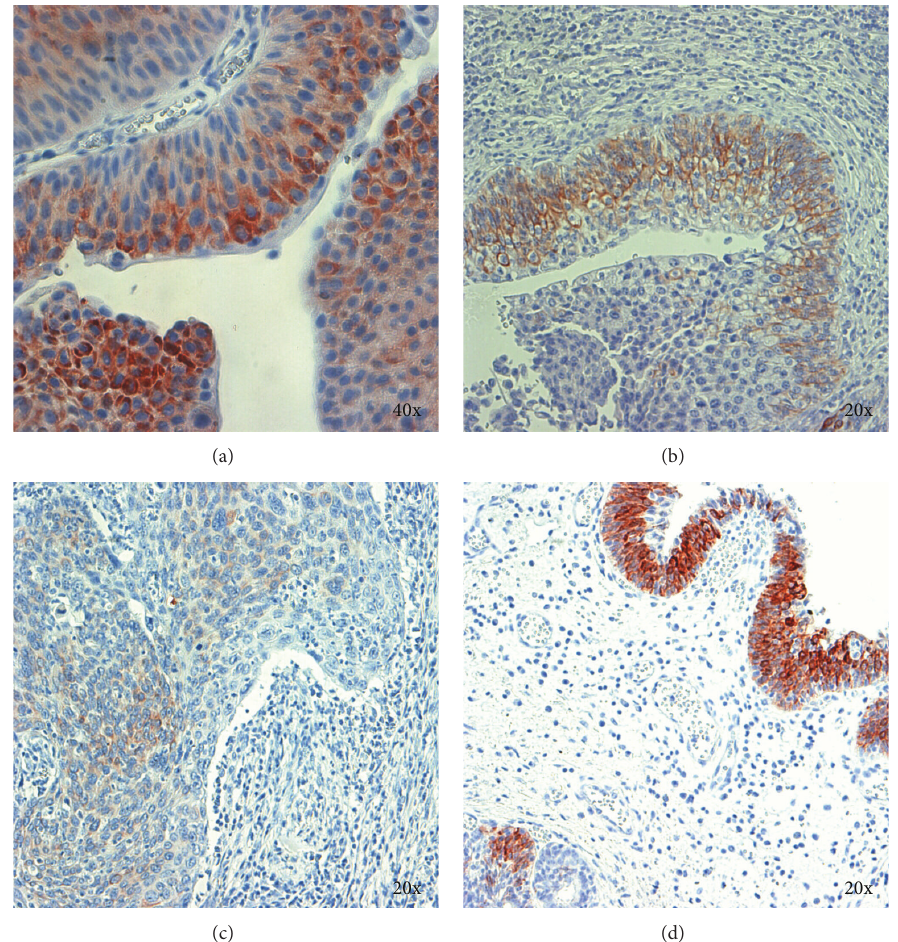
Figure 1: IL1RN expression was in general moderate to high in group 2 ((a) pTa low grade), decreased in group 3 ((b) pT1), and was significantly lower in group 4 ((c) pT3). Benign urothelial tissue (group 1) showed the most intensive staining